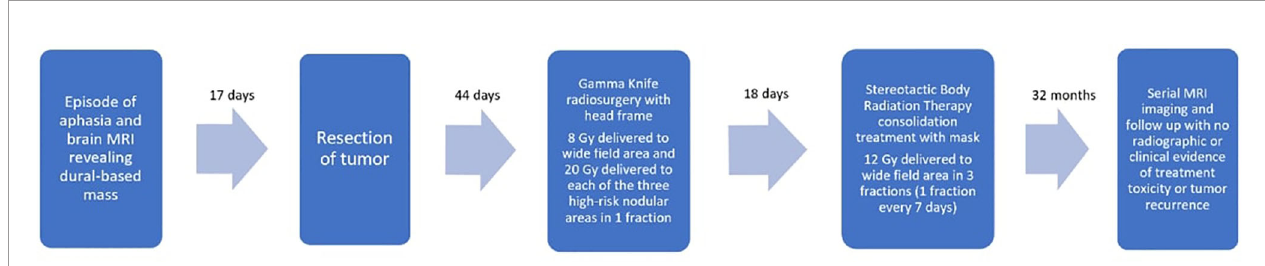
FIGURE 1 | Clinical and Treatment